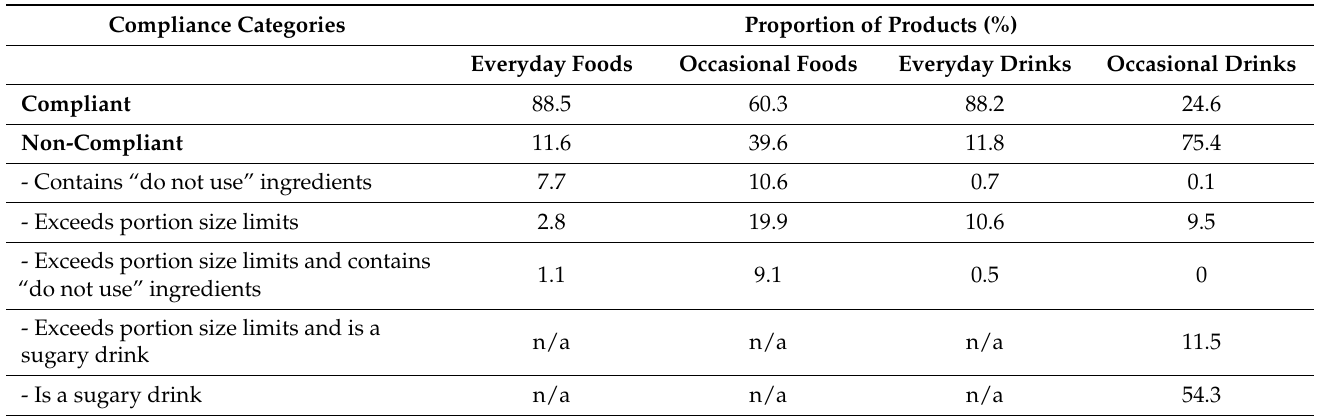
Table 4. Proportions of products across compliant and non-compliant categories based on portion size, quality of ingredients, and type of product as per the Framework